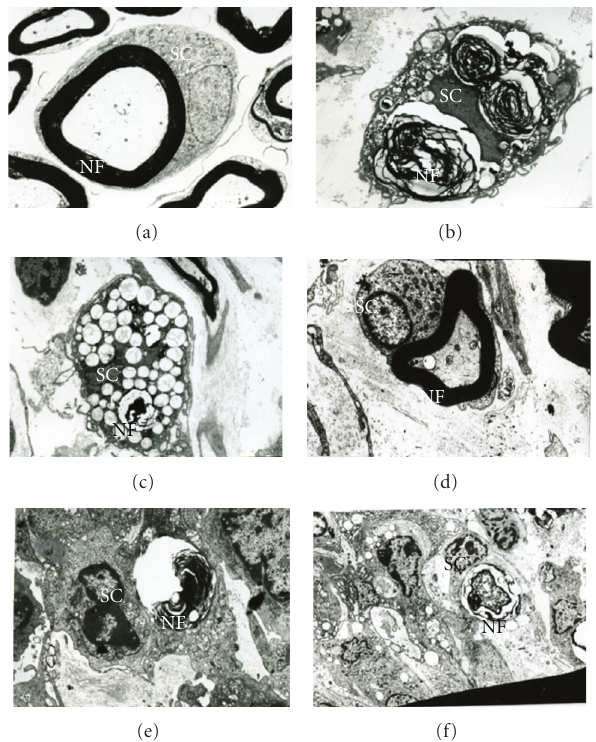
Figure 3: Electron microscopic analysis of autologous and xeno- geneic nerve grafts. Autologous (a)–(c) and xenogeneic mouse (d)– (f) nerve grafts were examined at weeks 2 (a) and (d), 4 (b) and (e), and 8 (c) and (f) posttransplantation. Five rats per group were analyzed at each time point (these are the same animals shown in Figure 1), and representative samples ( x 5,000) are shown. SC, Schwann cell; NF: nerve